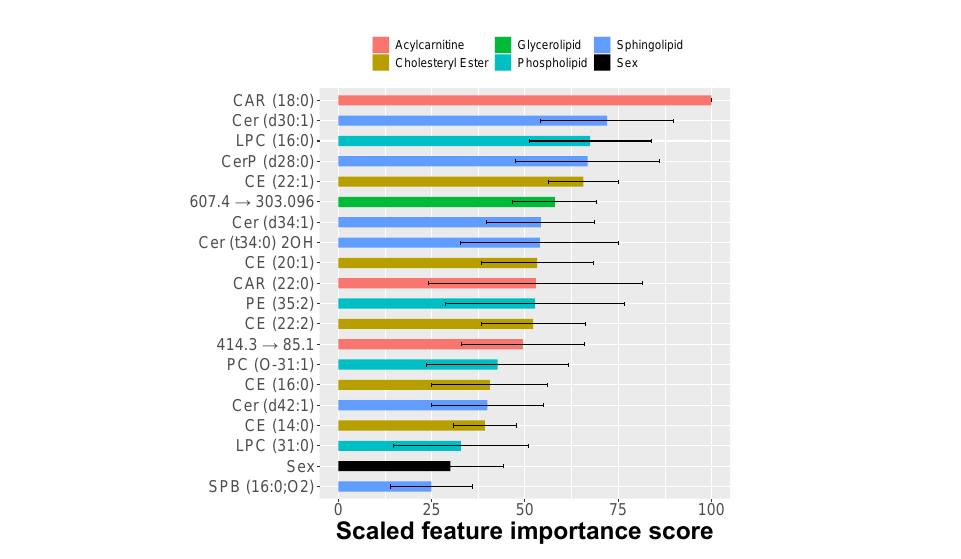
6 of 22 Figure 4. Comparison of effect sizes (standardized mean difference; top 25 absolute values) ob- served between lipid abundances present in swabs collected from CAD (lesional and nonlesional skin) vs. healthy dogs. The nonlesional skin is affected to a lesser extent than lesional skin. The profound differences in lipid composition allowed the training of an elastic net logistic classifier (ENET), which achieved a high accuracy (AUC = 0.95; CI = 0.91–0.99). The accuracy of the classifier could be treated indirectly as a measure of features’ quality and their association with the predicted outcome. In contrast to black-box classifiers, such as neural networks, the ante-hoc explainable ENET set-up allowed us to determine the list of the most predictive features. The ENET model identified the combination of CAR(18:0), Cer(d30:1), LPC(16:0), and CerP(d28:0) as the most predictive lipids (Figure 5). Interest-